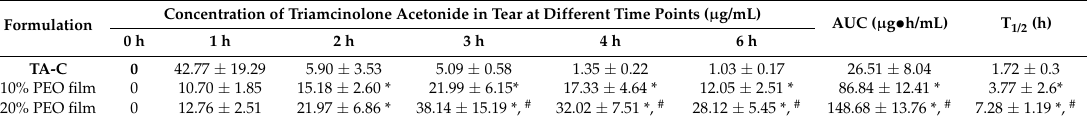
Table 2. In vivo tear kinetics of triamcinolone acetonide from TA-C and 10 and 20% PEO formulations (mean ± SD, n = 3). Concentration of Triamcinolone Acetonide in Tear at Different Time Points ( µ g/mL) AUC ( µ g • Formulation